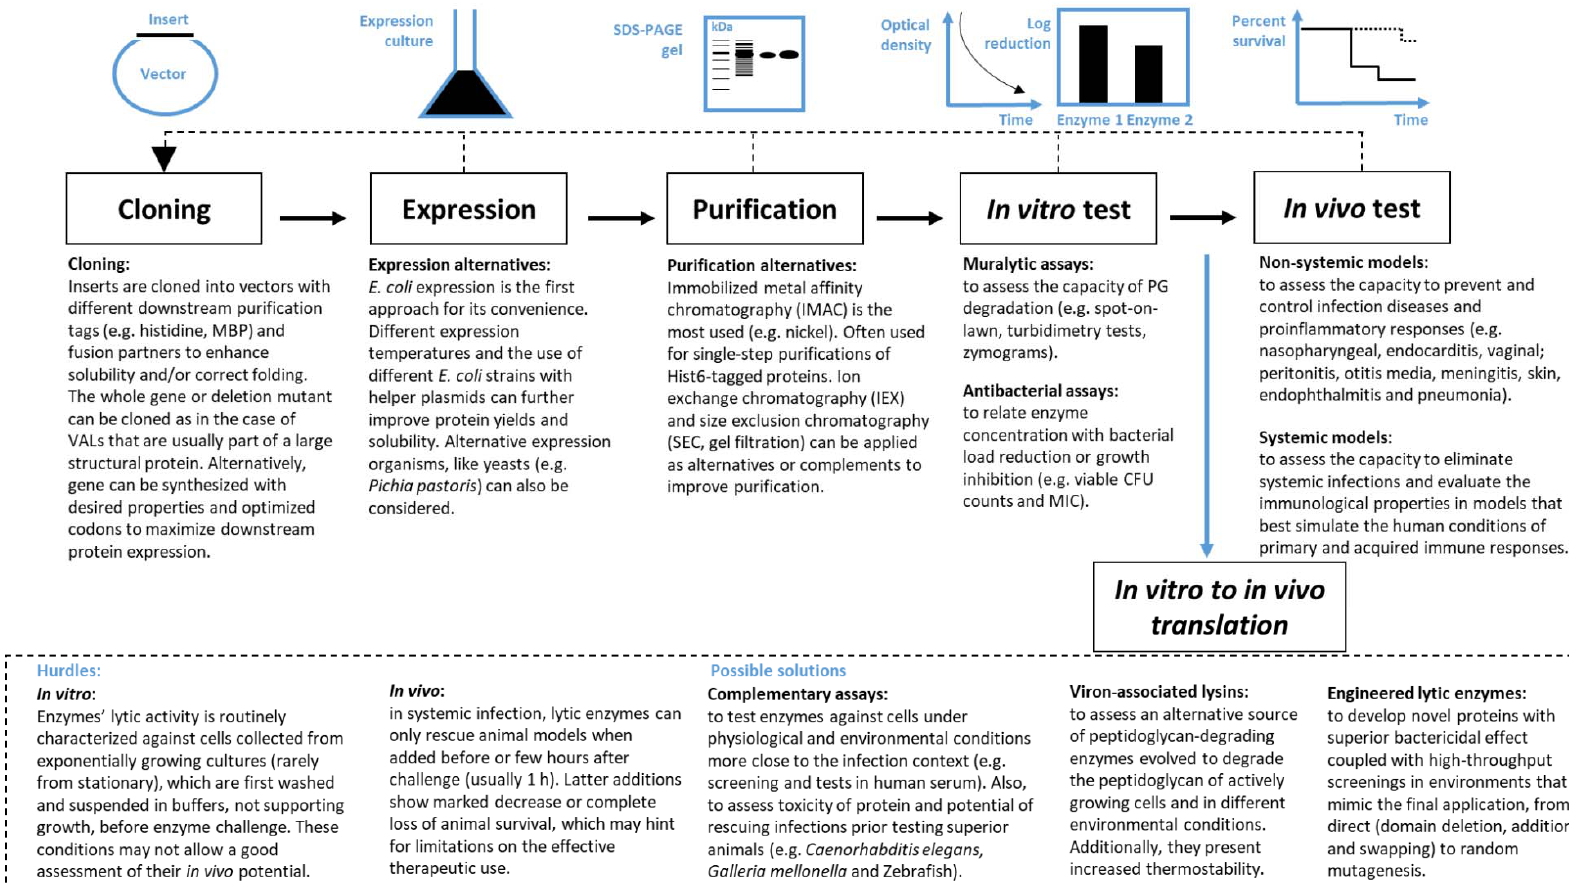
Figure 1. A step by step process for exploration and examination of the enzybiotic potential of phage-derived peptidoglycan-degrading enzymes. Five independent steps are identified in the flowchart, being the most common strategies used. An additional and intermedium step between in vitro and in vivo tests are discussed.